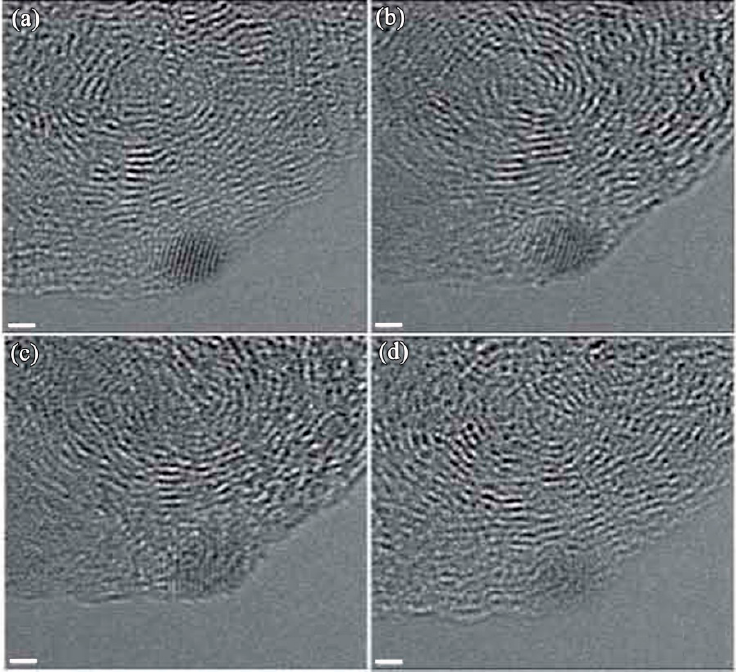
Figure 11. HRTEM images showing a nanodiamond forms from the anthracite upon exposure to the electron beam. The scale bar is 1 nm (Reproduced with permission from [100]).